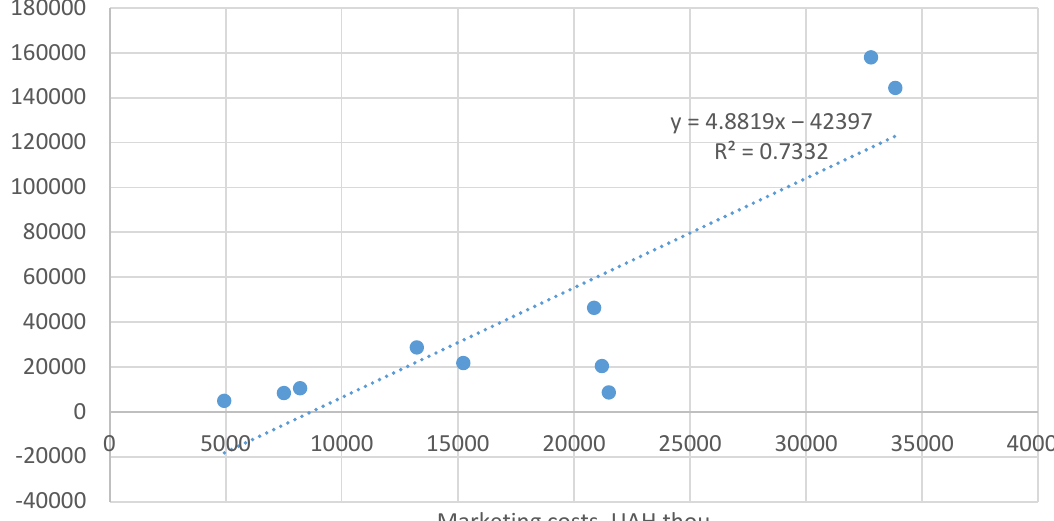
y = 4.8819x ‒ 42397